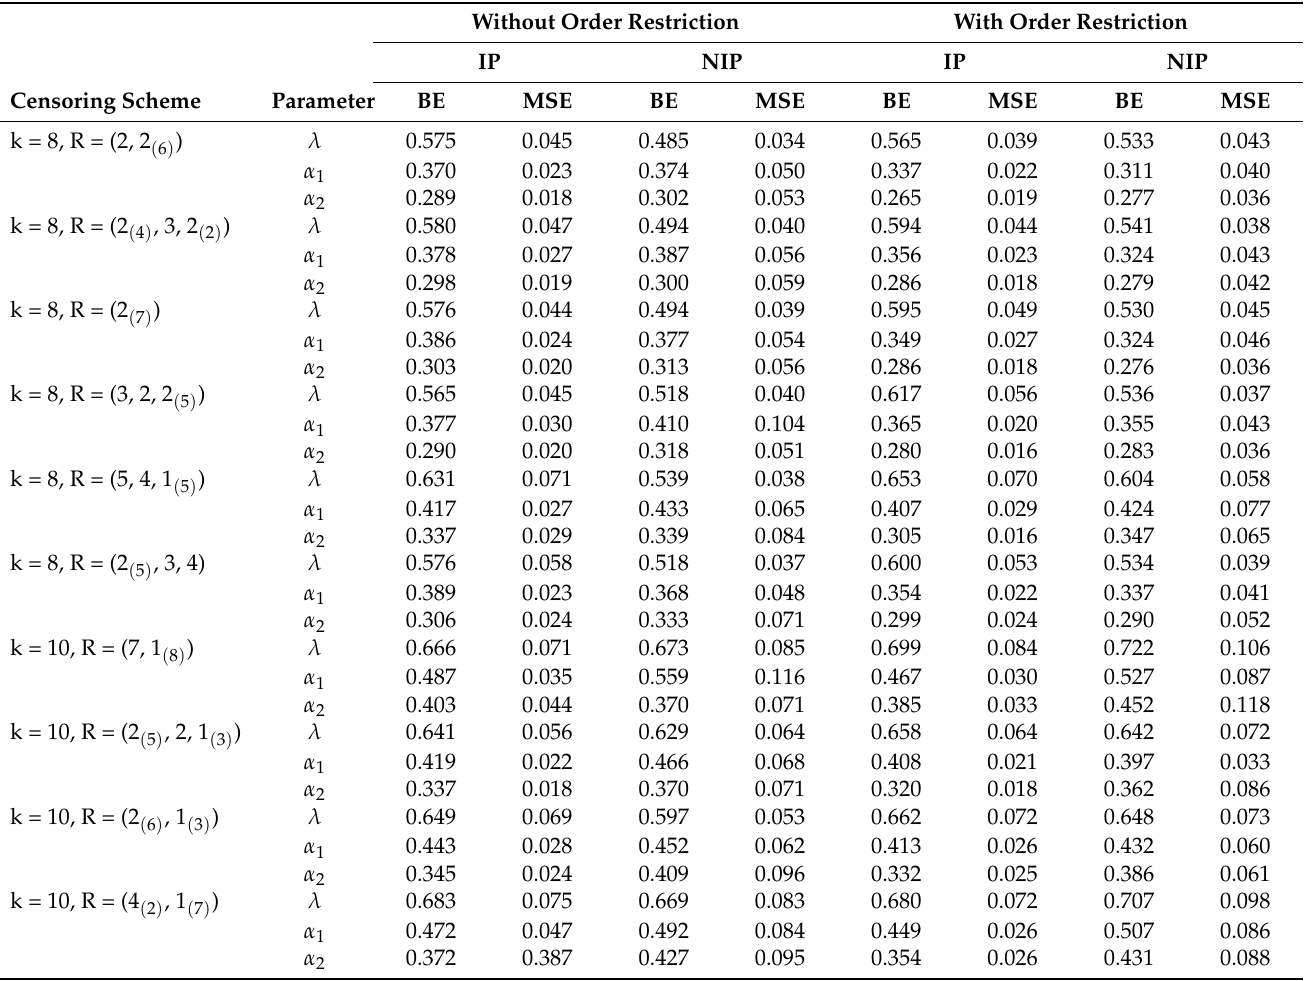
Table 5. MSEs and BEs of the Bayesian estimates of the model parameters with λ = 0.5, α 1 = 0.4, and α 2 = 0.3 based on the importance sampling procedure and different